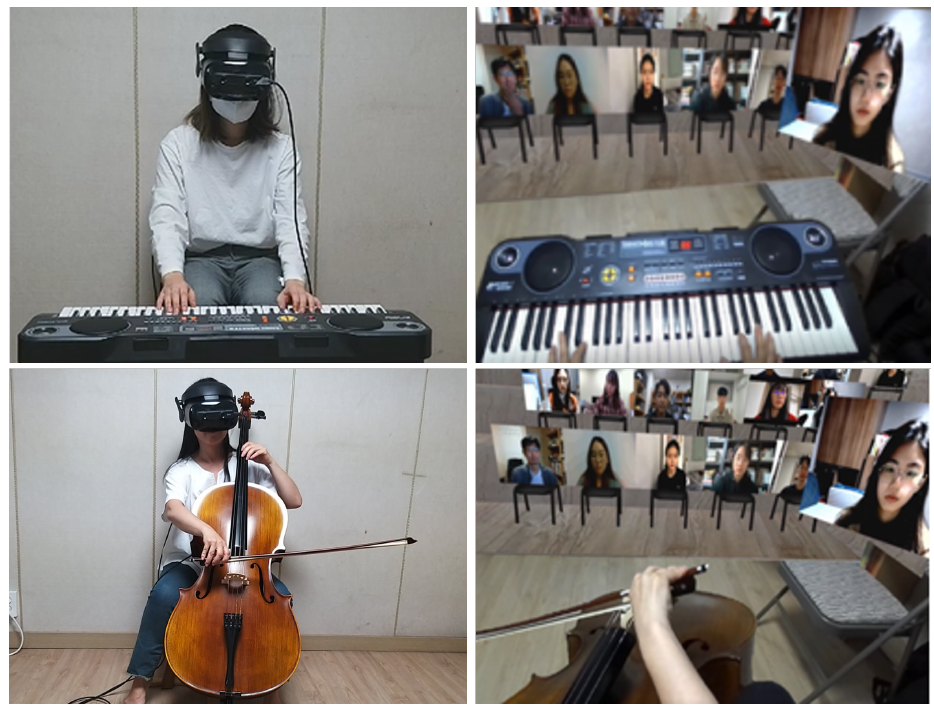
Figure 9. AudienceMR for stage